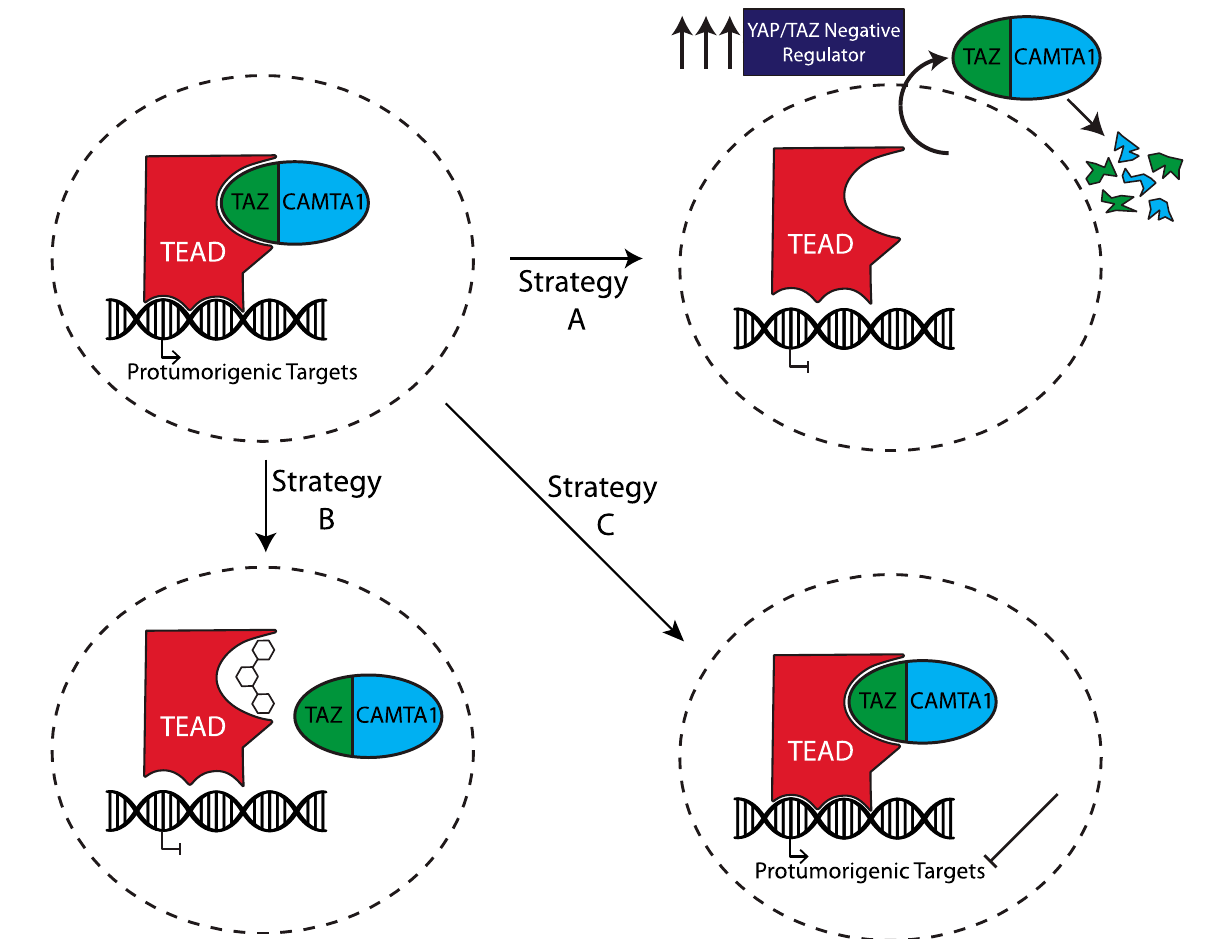
Figure 3. Strategies for targeting the oncogenic effects of TAZ–CAMTA1. Top left demonstrates the normal oncogenic effect of TC. Strategy A demonstrates inhibition of TC via increasing the action of negative regulators leading to cytoplasmic retention and degradation. Strategy B demonstrates inhibition by protein–protein interaction to disrupt the interaction between TC and TEAD proteins. Strategy C demonstrates inhibition of the downstream targets of TC/TEAD transcription, which promote oncogenesis.